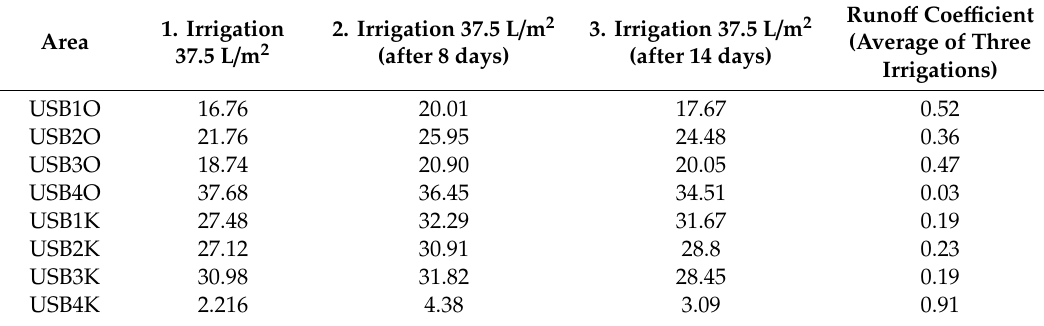
Table 5. Water retention after three irrigations with 37.5 L/m² (period: 24 July–20 August, 2018).